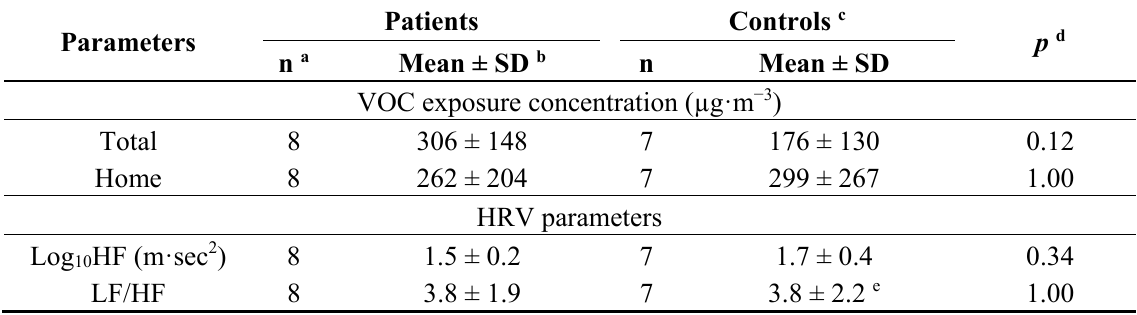
Table 1. Summary of VOC exposure concentrations and HRV parameters for patients and controls.